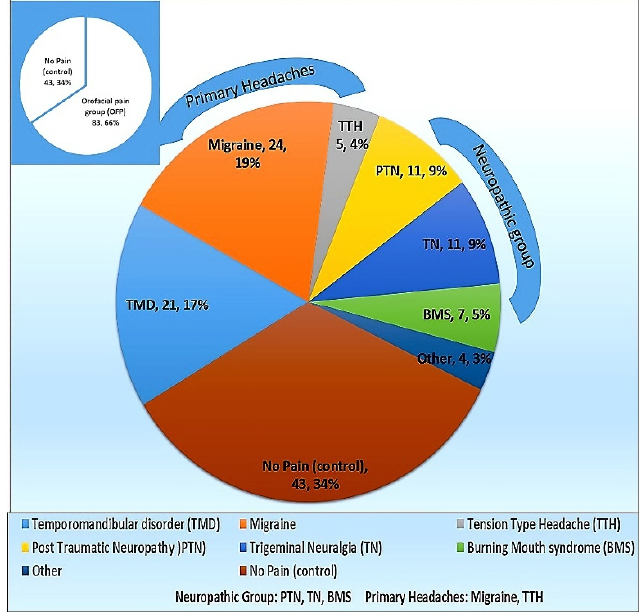
Figure 1. Cohort distribution according to the diagnosis.